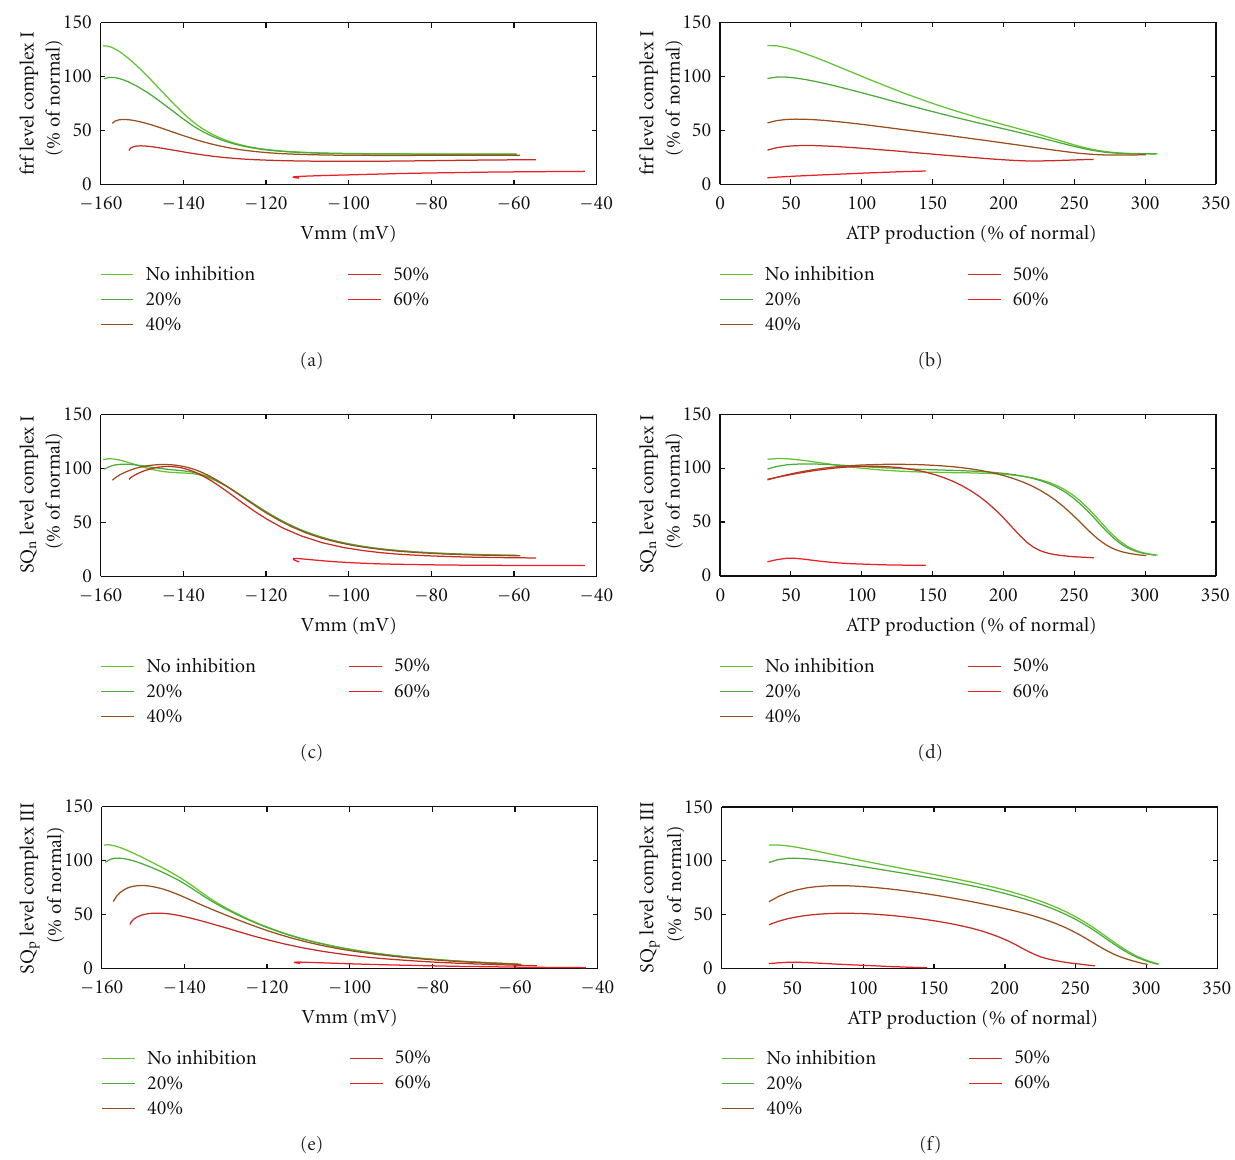
Figure 10: ROS production at inhibition of KGDHC. Levels of fully reduced flavin ((a) and (b)), semi-ubiquinone at n-site bound to complex I ((c) and (d)) and semi-ubiquinone at p-site bound to complex III ((e) and (f)) at various inhibitions (a) of KGDHC. The levels are depicted versus the mitochondrial membrane potential ((a), (c), and (e)) and the ATP production rate ((b), (d) and (f)). Values except membrane potential are normalized to the reference